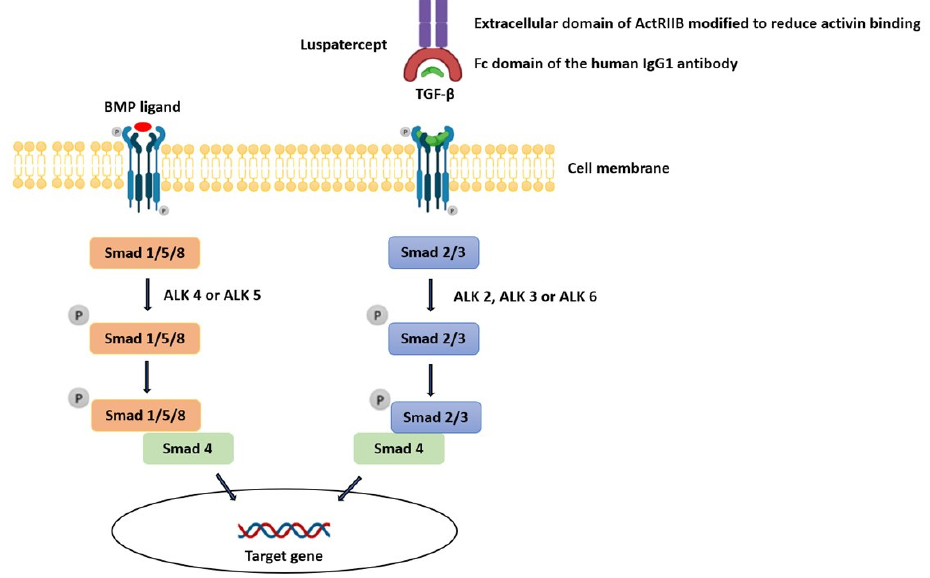
Figure 3. Influence of luspatercept on the TGF- β pathway.